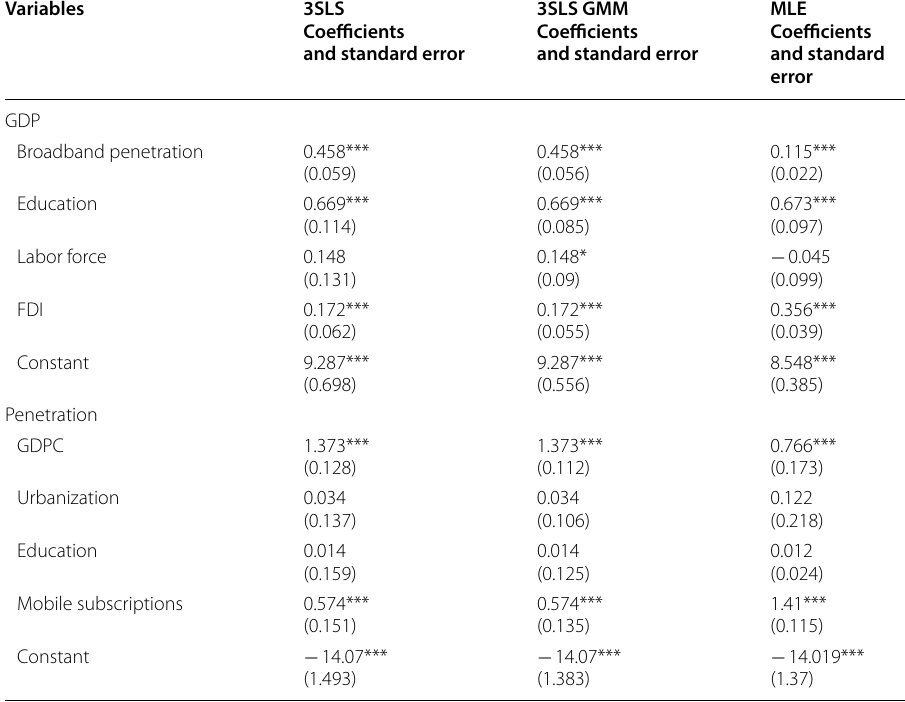
All variables are in log